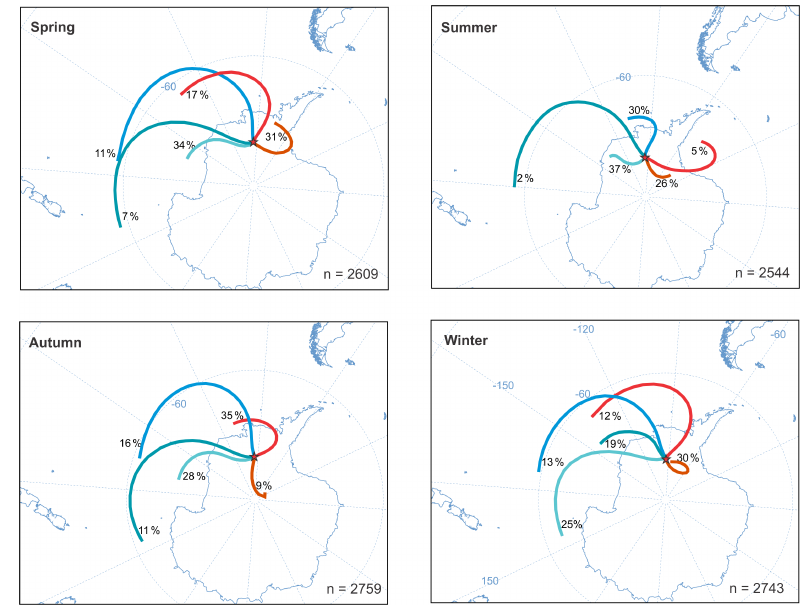
Figure 8. HYSPLIT seasonal clusters of daily 5-day back trajectories from 1979 to 2008 arriving at the Mount Johns ice core site, West Antarctica. Percentage of daily trajectories included in each cluster is indicated; number of daily trajectories for each season is indicated at the bottom right of each panel. Blue represents oceanic group clusters, while red shows the continental group clusters. Trajectories calculated using the NOAA HYSPLIT model (version